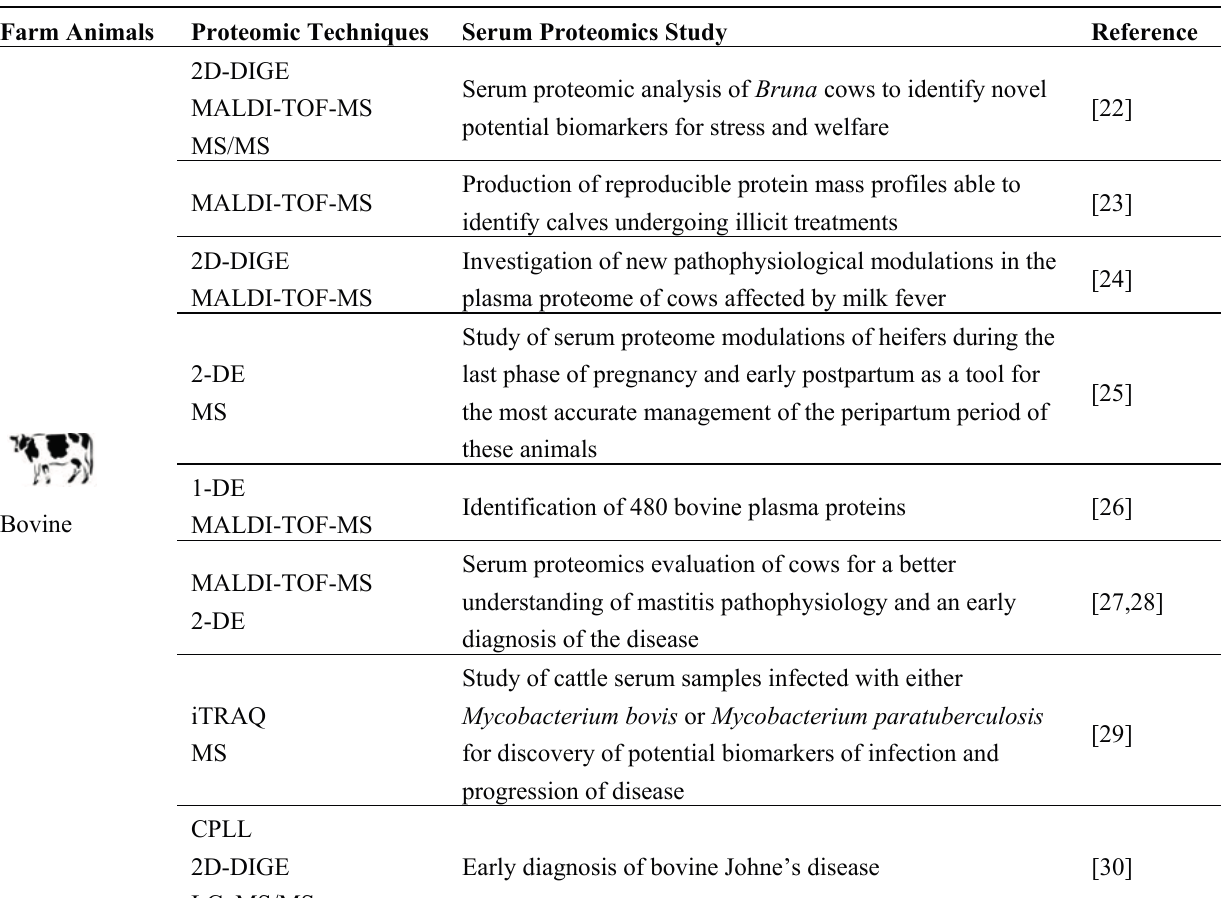
Table 2. Some applications of serum proteomic approaches in the veterinary field. Farm